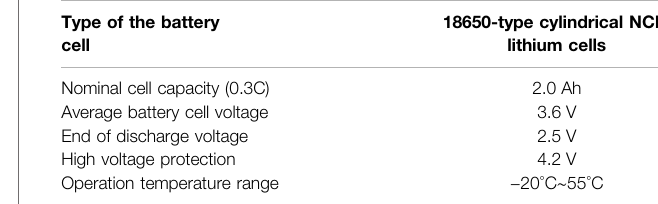
TABLE 1 | List of main parameters of the